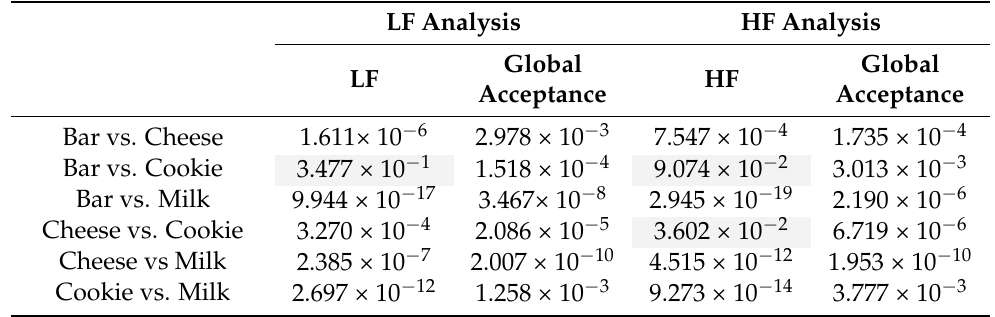
Table 7. p -values obtained from the Wilcoxon analysis intended to check significant differences between products concerning features values (HF and LF) and global acceptance scores. The LF analysis was conducted from a set of 162 experiments (set without LF outliers) and the HF analysis from a set of 156 experiments (set without HF outliers). The grey cells indicate pairs where no significant difference was found ( p -value >